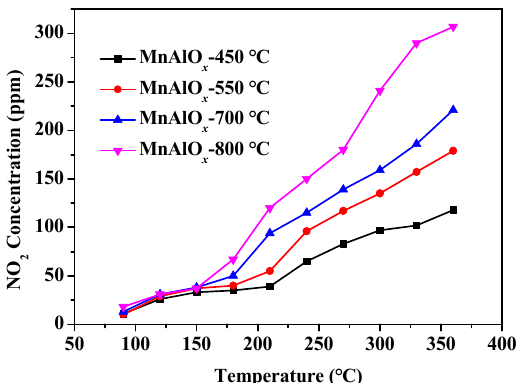
Figure 11. NO oxidation to NO 2 over the MnAlO x catalysts with different calcination temperatures. Reaction conditions: [NO] = 500 ppm, [O 2 ] = 6.5 vol.%, N 2 as balance gas, total gas flow rate 400 mL/min, and GHSV = 12,000 h − 1 .